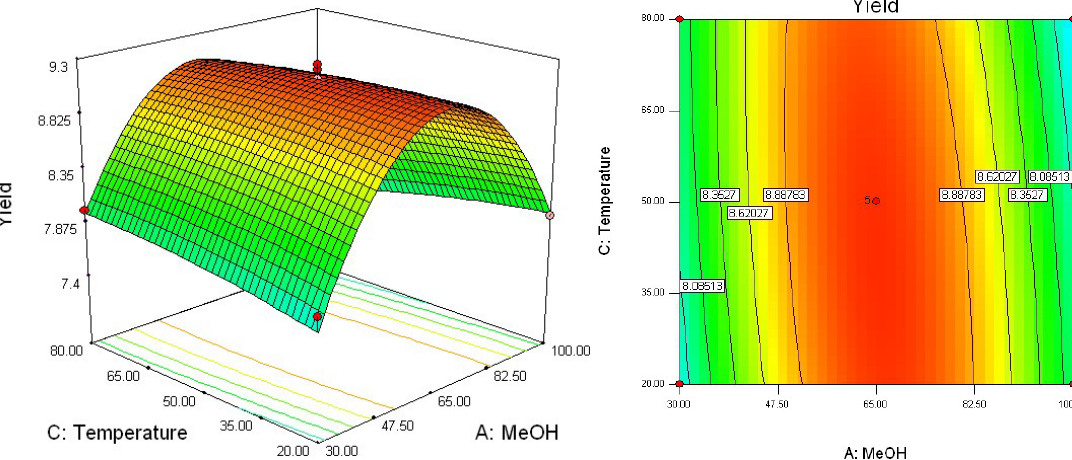
Figure 3. Response surface plot of methanol concentration and extraction